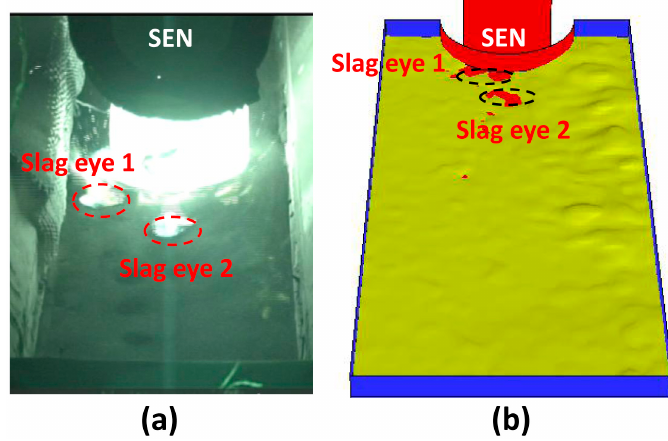
Figure 3. The slag eye on top surface: ( a ) on-site observations and ( b ) predicted results.